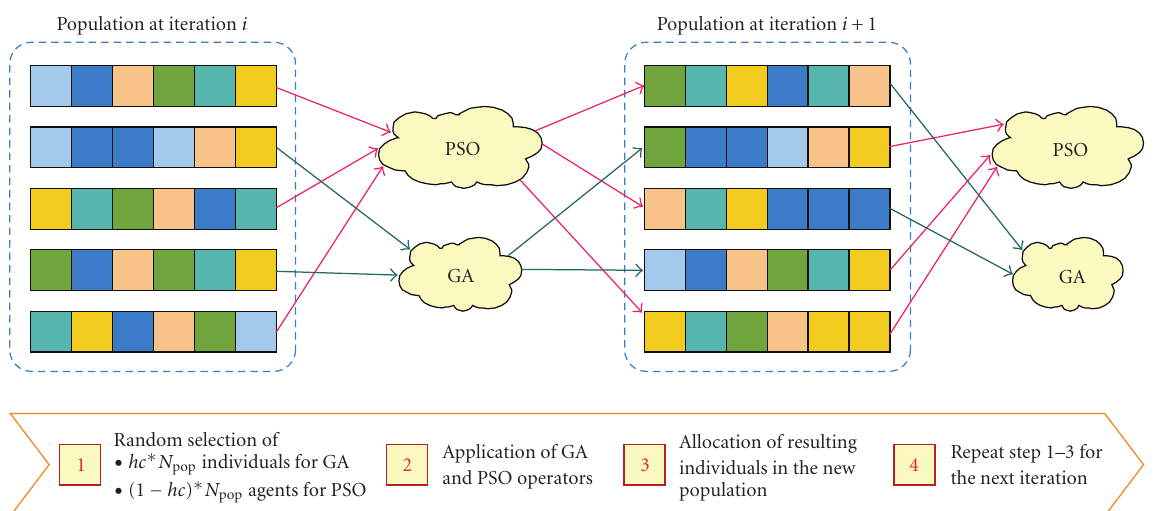
Figure 1: Basic steps in hybridizing GA and PSO and setting up population for GSO